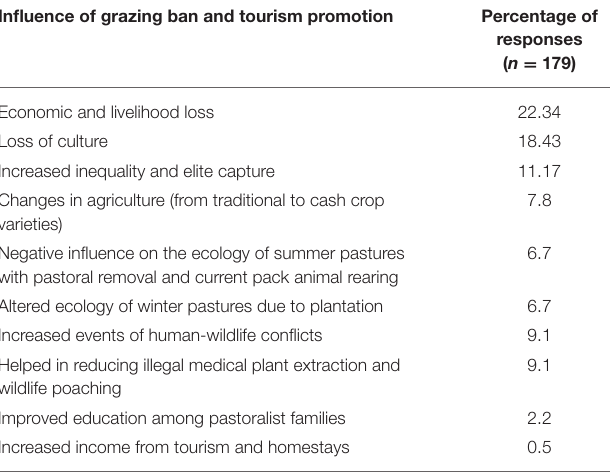
TABLE 1 | Locally perceived influence of grazing ban and tourism in